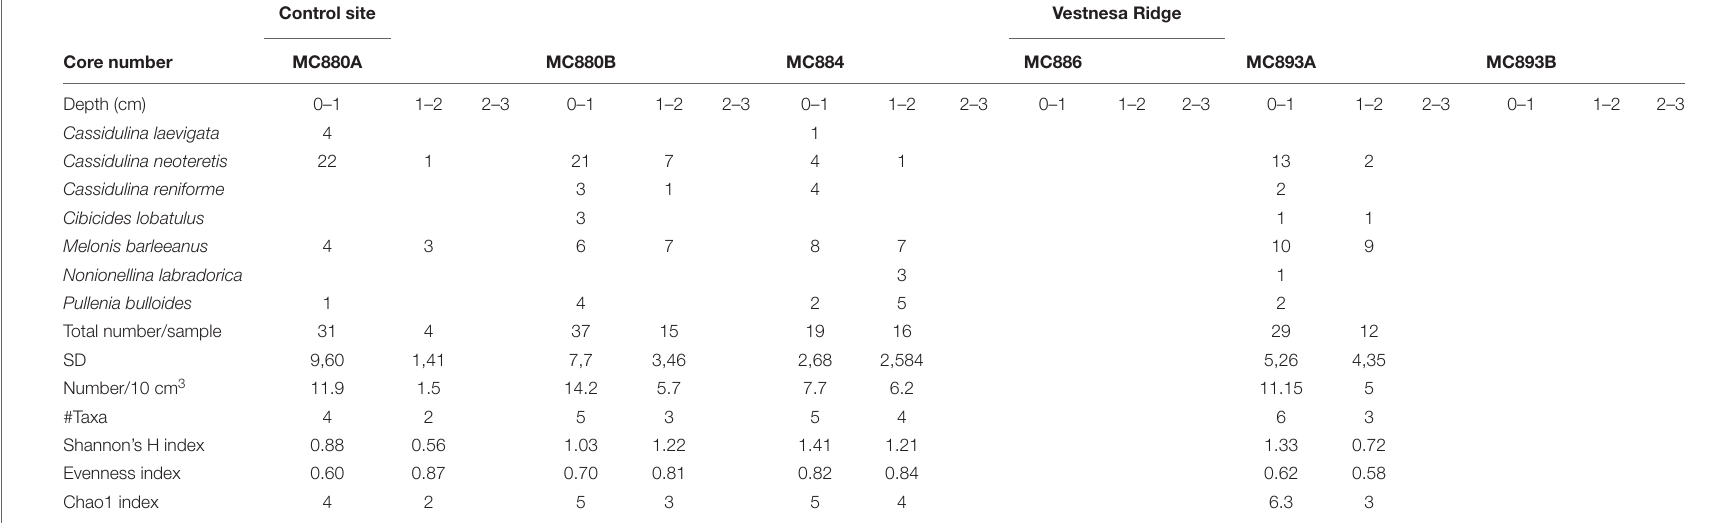
TABLE 2 | Direct counts of CellTracker TM Green labeled foraminifera from all